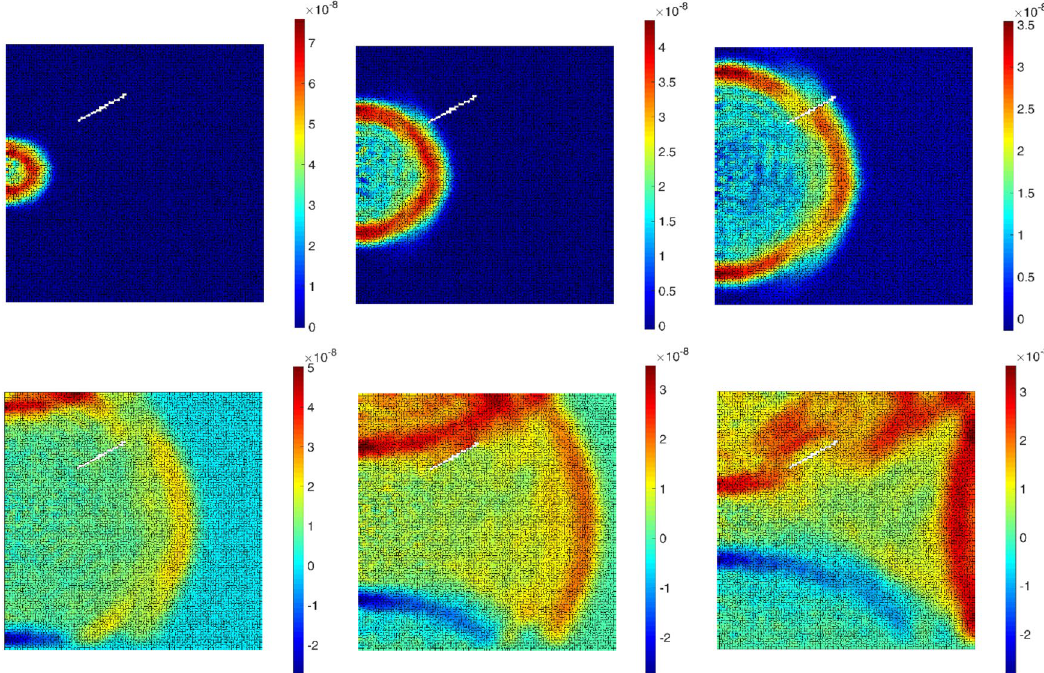
Figure 6. The 6 frames (100 time-steps interval, from left to right) of a displacement ( u x ) wave propagation inside the defined plate in Fig.